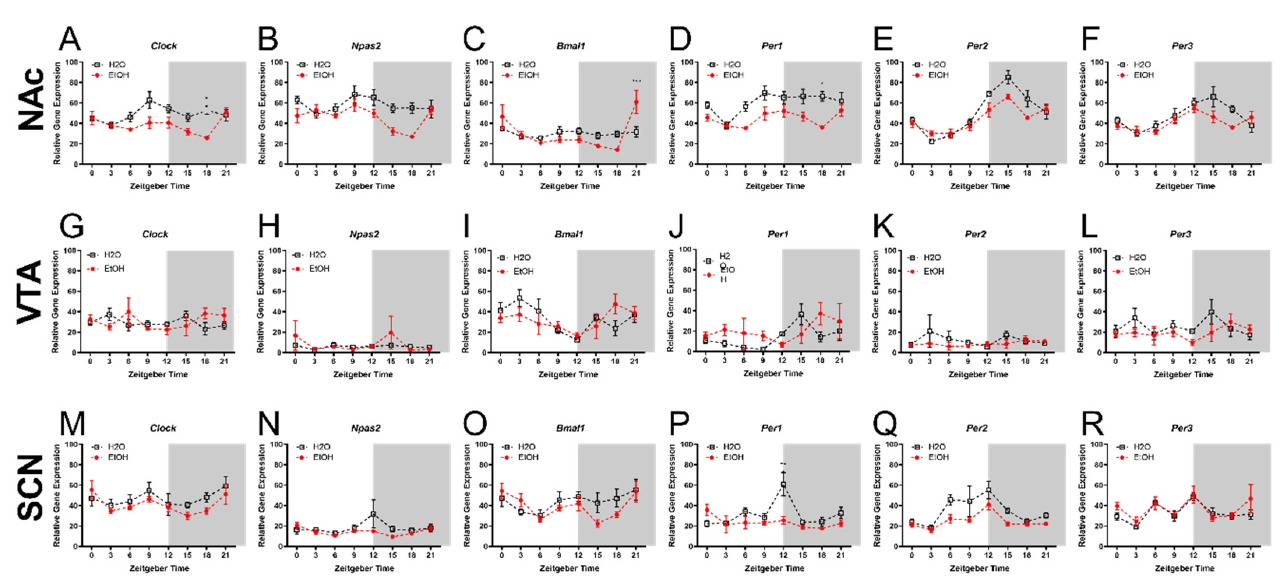
Figure 1. Chronic binge-like ethanol intake reduces NAc and SCN expression of circadian genes in female HDID-1 mice. Detailed descriptive statistics are provided in Table 1. The following core cir-